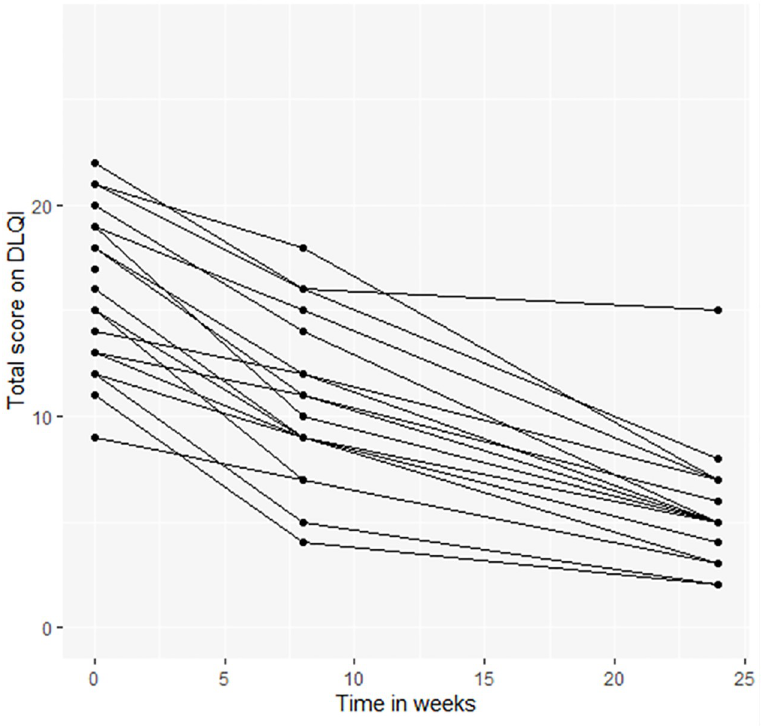
Fig 2. Change in total score on DQLI over time for podoconiosis patientin Bahir Dar, Ethiopia between January 2015 and December 2019. Time 0 is before the first surgery. DLQI: Dermatology Life Quality Index.